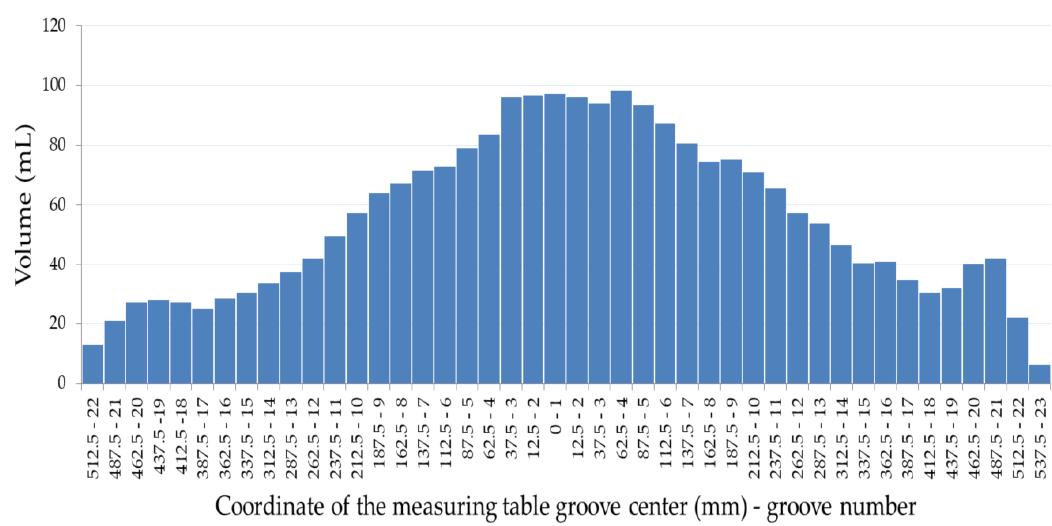
Figure 5. Histogram of volume distribution for nozzle number 2 (RS11003).